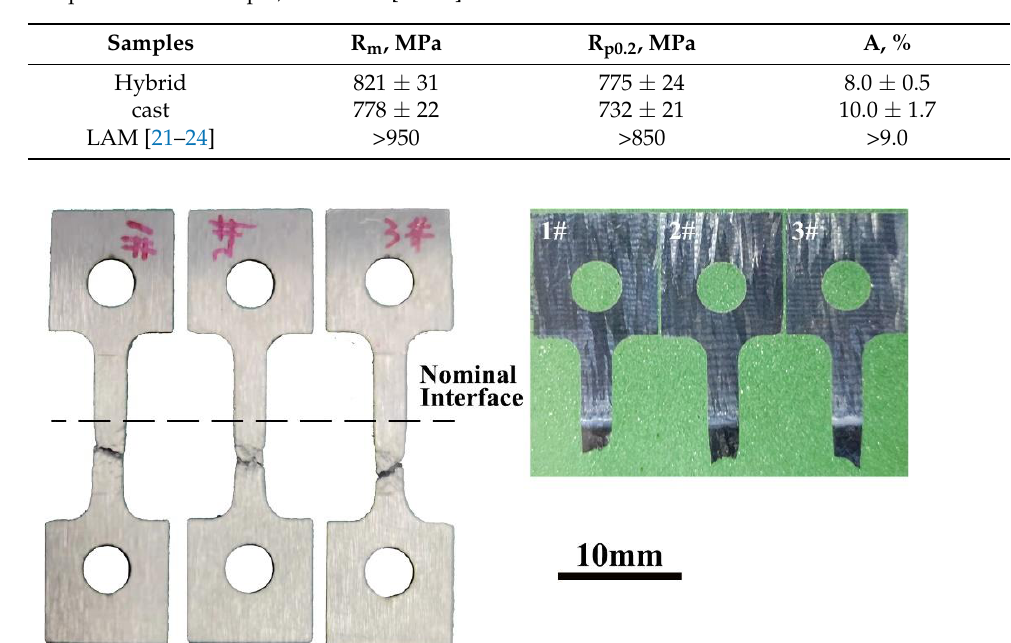
Figure 5. Hybrid samples after tensile test showing the fracture position.